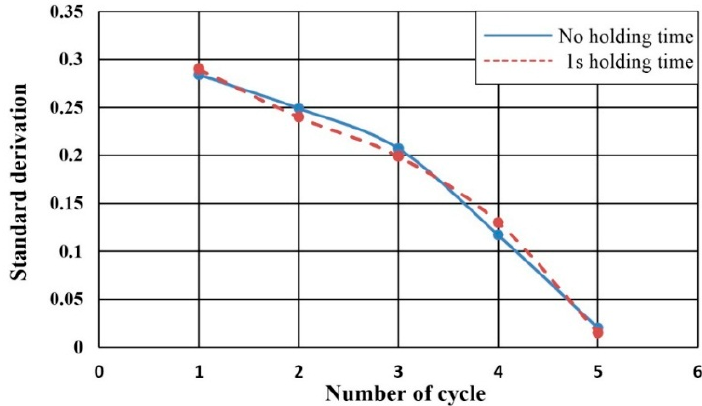
Figure 9. Comparison of the standard deviation of the mixing performance with and without the holding phase.